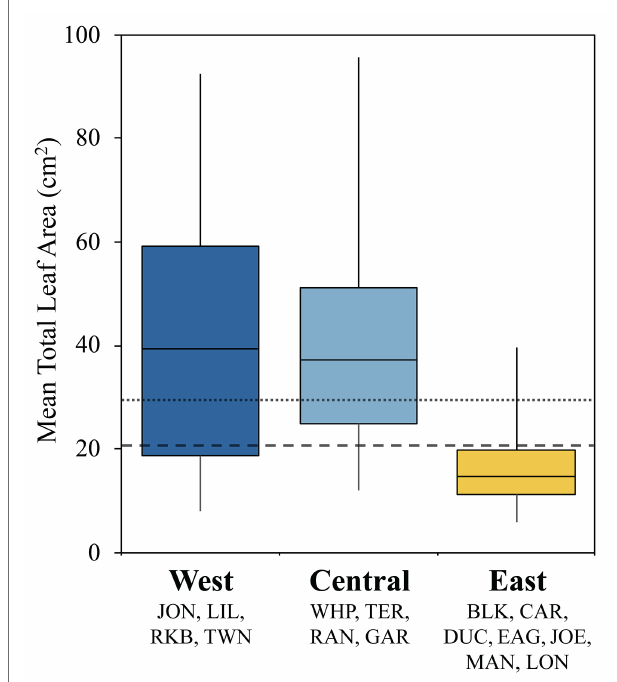
FIGURE 3 | Box plots displaying turtlegrass mean leaf area per shoot (cm 2 ) collected biannually from January 2010 to May 2015 as a function of immune class. Sample sizes as follows: West, n = 56; Central, n = 53; and East, n = 97. Boxplots represent the interquartile range (IRQ) centered around the median of the data. Whiskers signify the minimum and maximum spread of the data outside of the IRQ. Fine and coarse dashed lines represents the mean (29.26 cm 2 ) and median (20.50 cm 2 ) values across all sites, respectively. Data obtained through Fisheries Habitat Assessment Program (FHAP) survey database (M. Durako, pers.